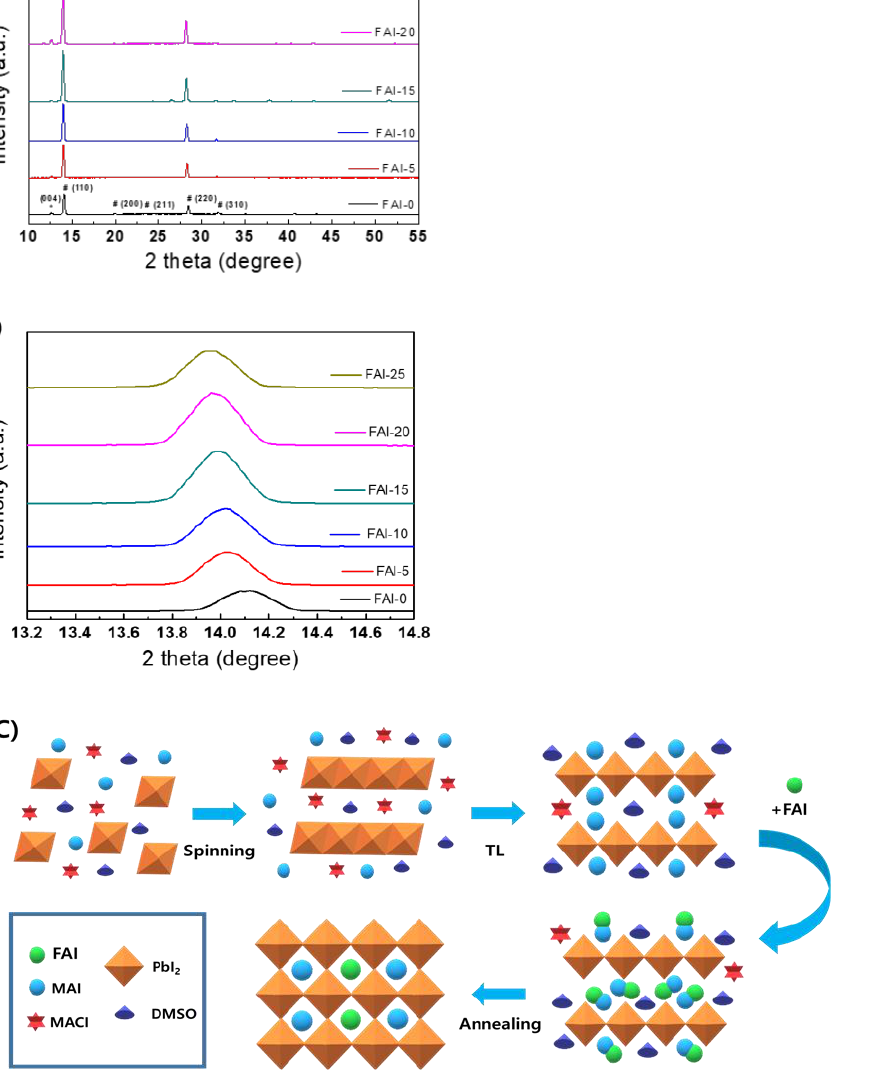
Figure 2. ( a ) XRD pattern of film subjected to post-treatment process with different concentrations of FAI. ( b ) Magnified XRD region for peak (110) of the FA x MA 1 − x PbI 3 perovskite film. ( c ) Schematic diagram of perovskite formation prepared via FAI post-treatment process.